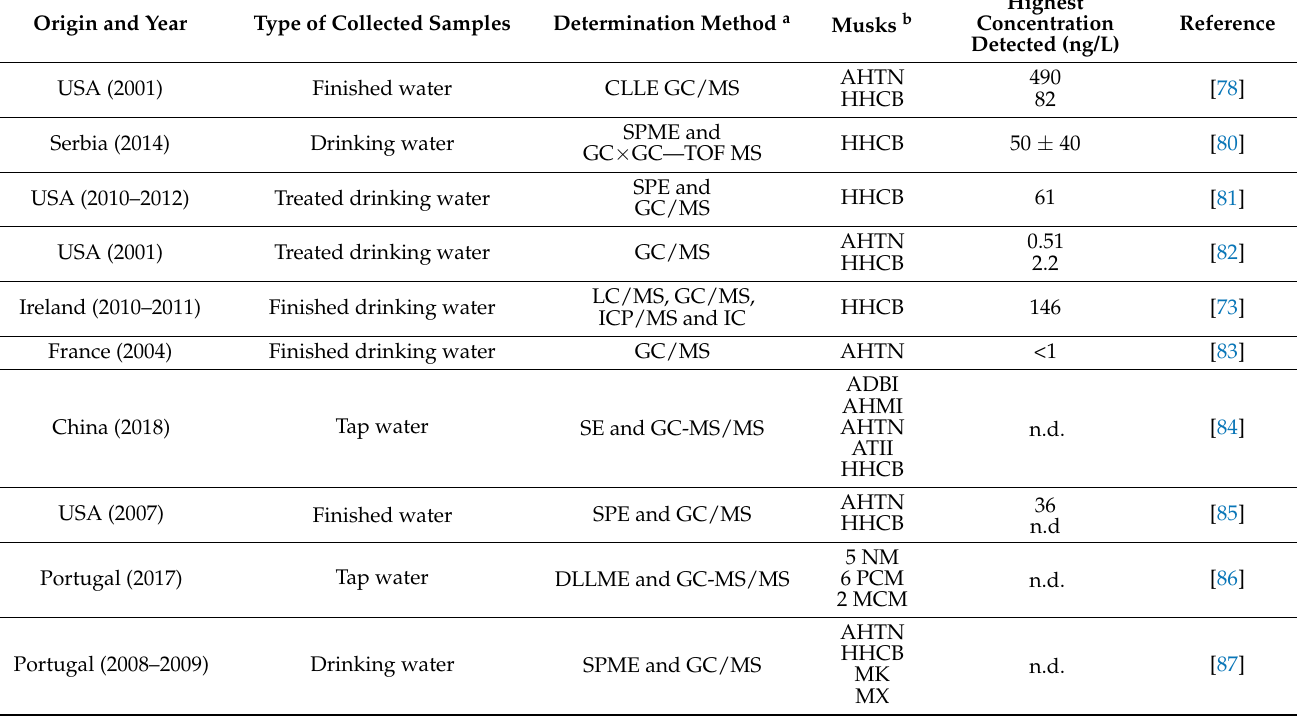
Table 2. Presence of musks in finished drinking water (effluent/reservoir in DWTPs) and in tap